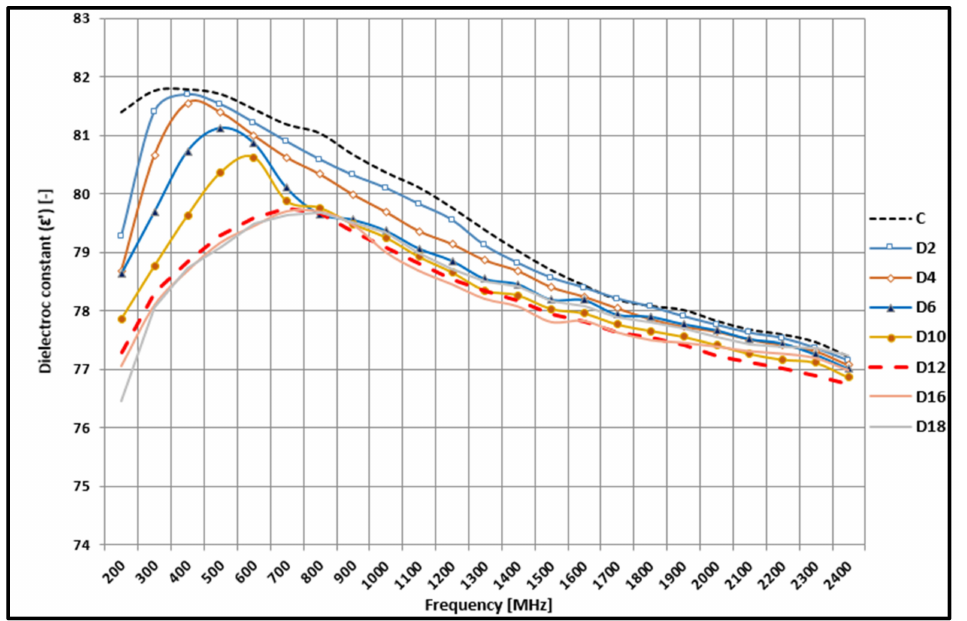
Figure 9. Trends of the dielectric constant during the fermentation of the control (non-treated)